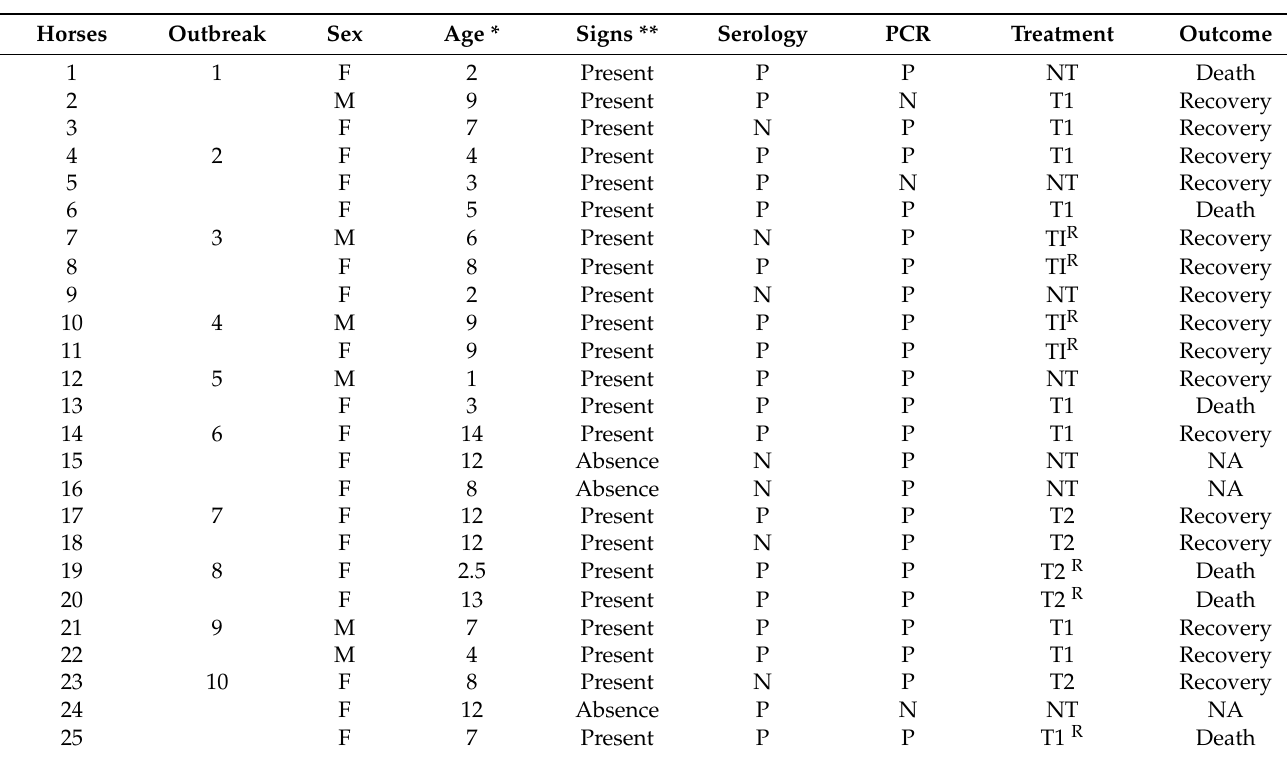
Table 1. Identification of animals and outbreaks, sex, age, presence of neurological signs, serol- ogy, nested PCR results and cases outcome of 25 horses suspected of equine herpesvirus myeloen- cephalopathy in the state of Par á , Amazon,